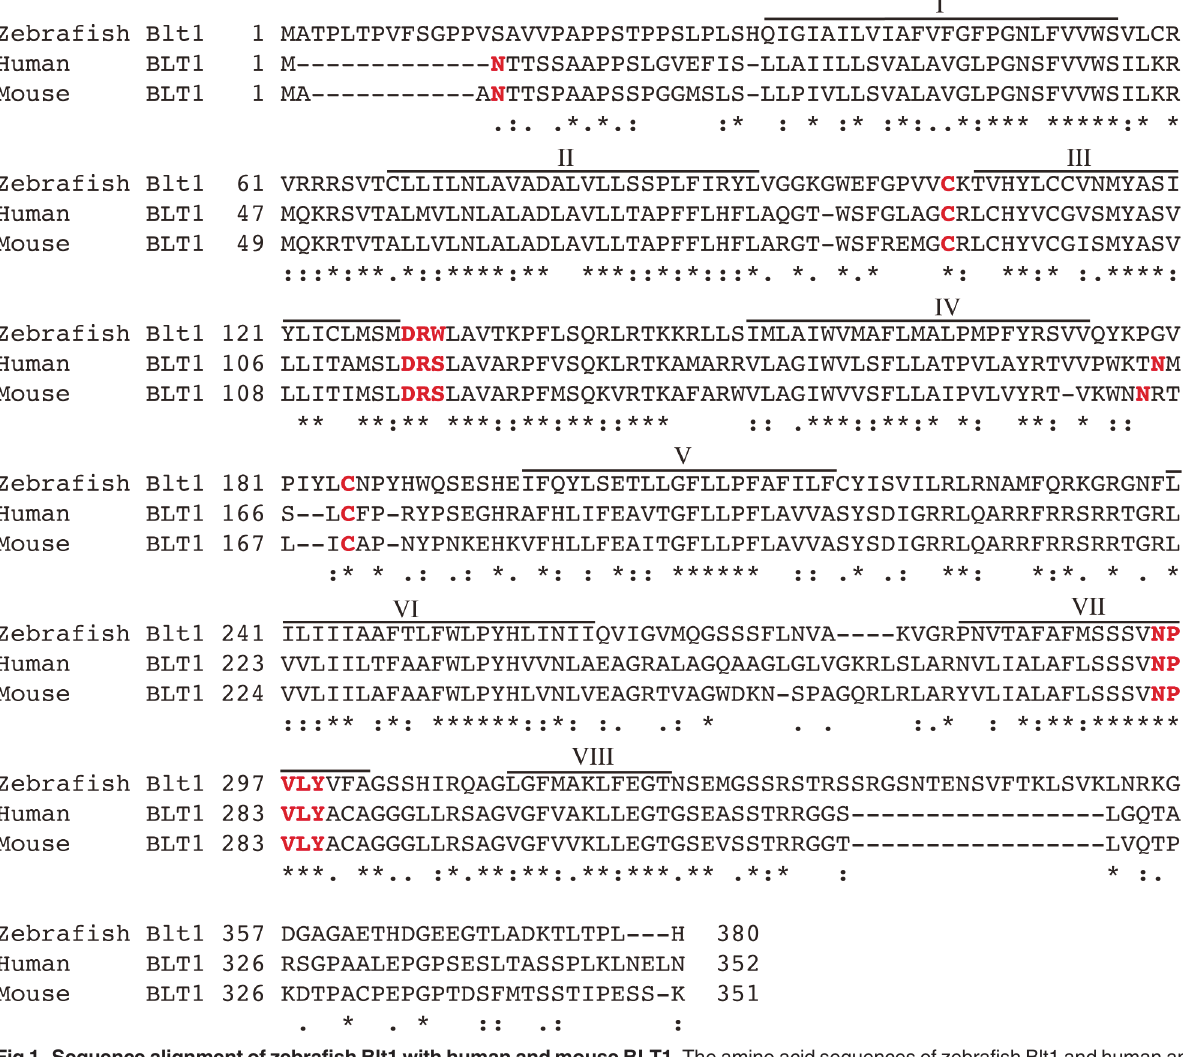
Blt2a (Fig. 7E), and zebrafish Blt2b (Fig. 7F) cells. These results suggest that zebrafish Blt1 is a BLT1-type receptor, and zebrafish Blt2a and Blt2b are BLT2-type receptors.